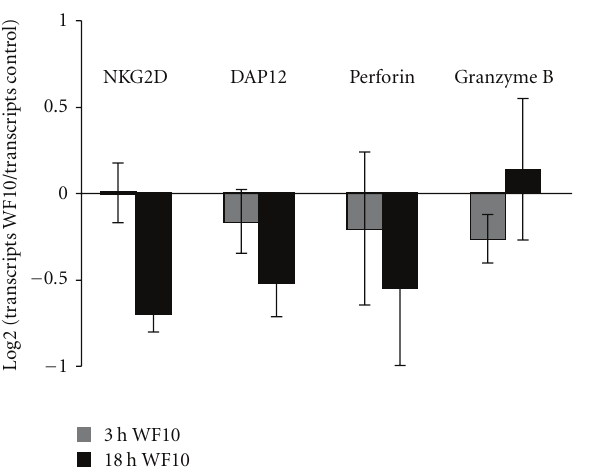
Figure 4: The e ff ect of WF10 on the transcription of NK cell genes. Freshly isolated NK cells were incubated with WF10 (at a chlorite concentration of 200 μ M) for 0, 3, or 18h and mRNA was isolated. The indicated transcripts were quantified by quantitative RT-PCR. The number of transcripts of individual genes in each sample was normalised using the number of transcripts of the house-keeping genes β -actin and cyclophilin b. The number of transcripts in the WF10-treated sample was compared with the number of transcripts in the control sample using the formula log2 (transcripts WF10 sample/transcripts control sample). Average values and standard deviation from 5 independent experiments with di ff erent blood donors are shown.